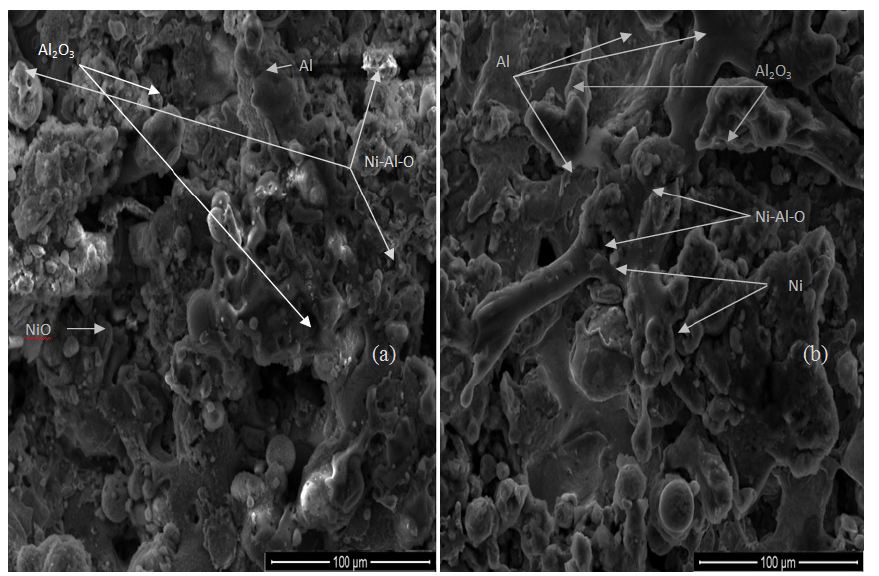
Figure 2. Scanning electron spectroscopy (SEM) photos of ( a ) NiO-Al and ( b ) Ni-Al coatings and ( c , d ) corresponding X-ray diffraction (XRD)